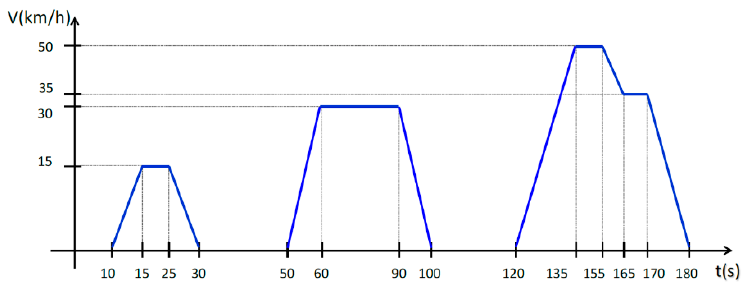
Figure 12. Driving profile ECE-15.